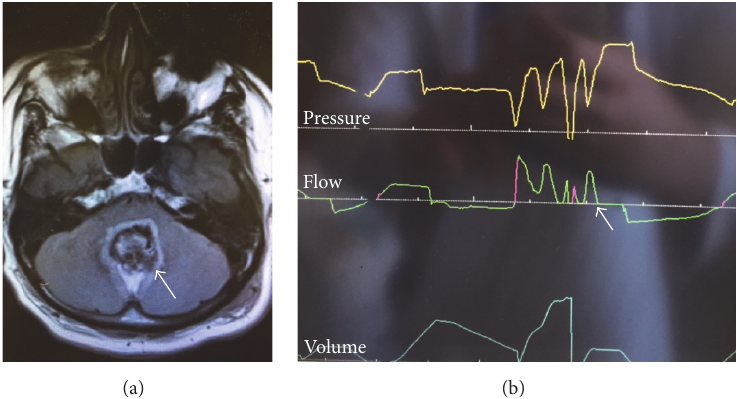
Figure 2: Magnetic resonance imaging of the brain. (a) T2 fluid attenuated inversion recovery (FLAIR) sequence showing medulloblastoma status after resection causing effacement of the fourth ventricle (arrow). (b) Ventilator picture showing cluster breathing pattern (arrow).